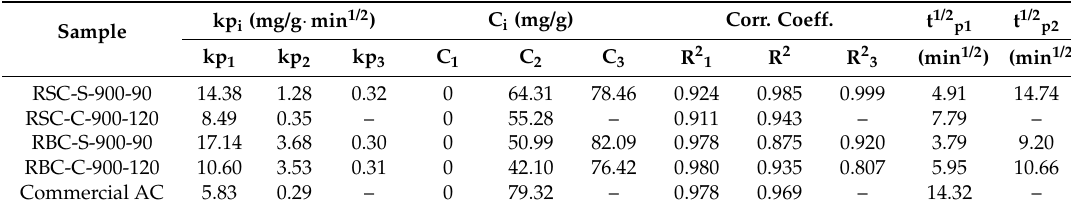
Table 6. IPD model constants and correlation coefficients for the adsorption of phenol on selected ACs derived from RSC and RBC, compared to commercial